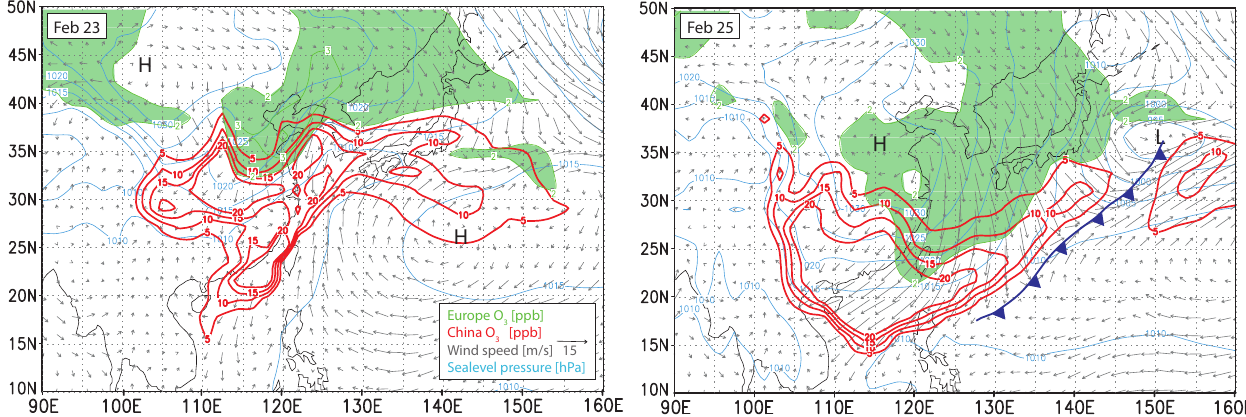
Fig. 12. Chinese and European contributions to O 3 and CO over Japan at 00:00 UTC on 23 and 25 February 2001 showing the development and movement of air masses associated with a developing frontal system (approximate position on 25 February marked in blue).